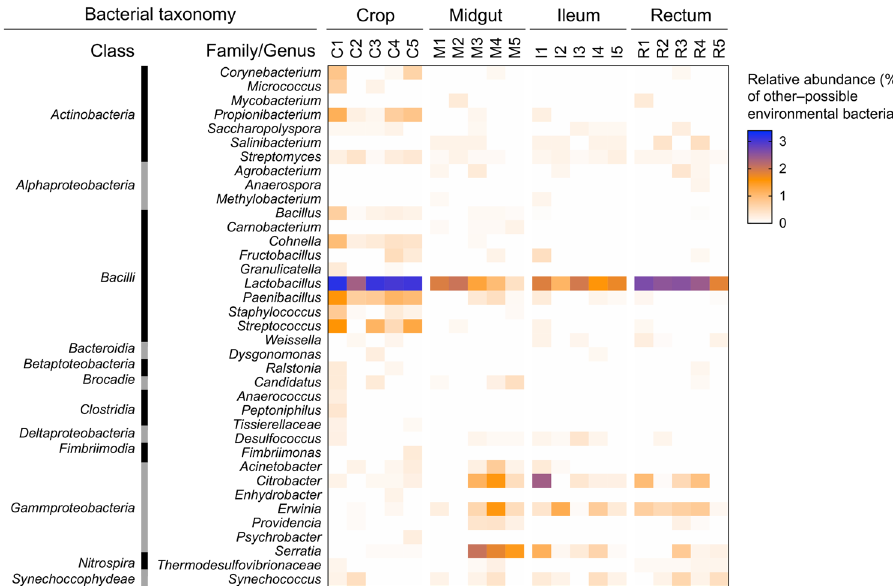
Fig. 4 Distribution of other-possibly environmental bacteria along the honeybee gut compartments. Heat map represent the distribution of other-possibly environmental bacteria classes and families/genera detected from the analysis of the total bacterial communities (i.e., DNA; Fig. 2f) along the four gut compartments (the crop, midgut, ileum, and rectum); values are expressed as the relative abundance (%) of the normalized reads.